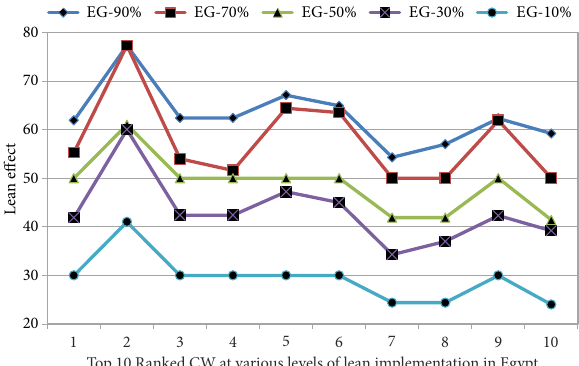
Figure 7. Lean effect for top 10 ranked CWs in Egypt